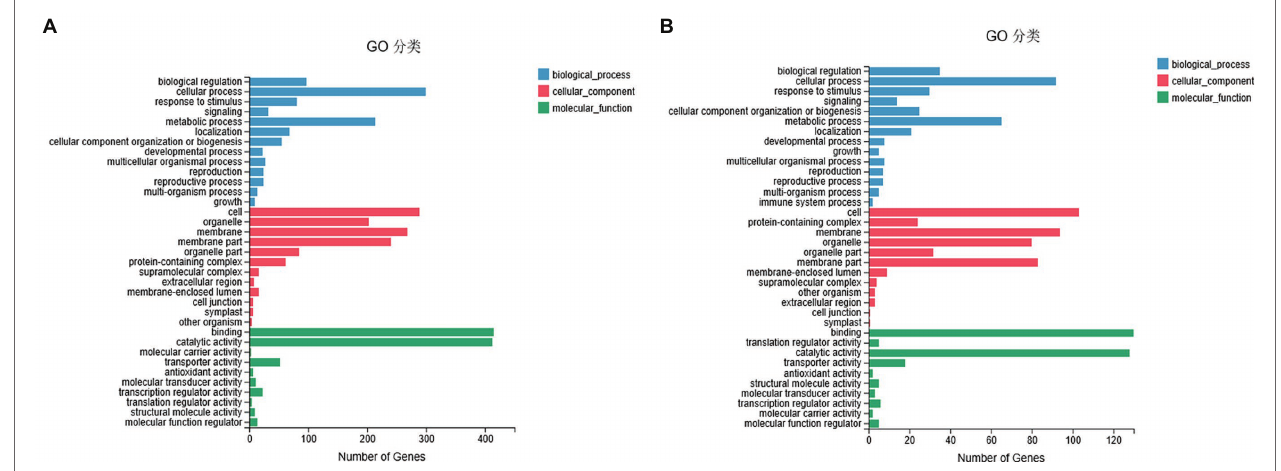
FIGURE 5 | Gene ontology classification of DEGs in differentially methylated region (DMR)-associated genes (A) /promoters (B) groups between 07-113A and 07-113B.